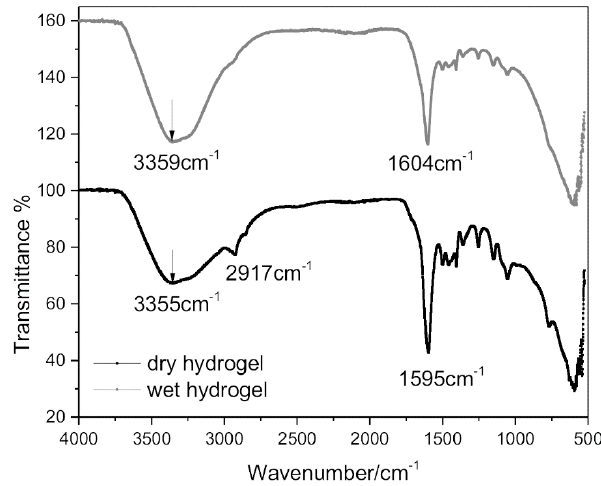
Figure 7. FT-IR spectrum of Nano-Al 2 O 3 -AD hydrogel in wet and dry state.